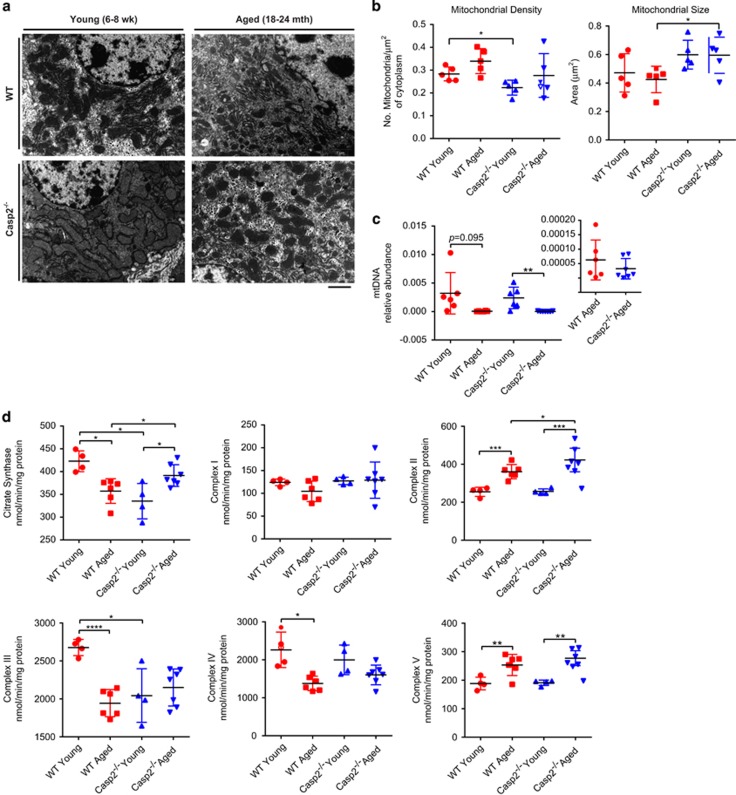
Altered mitochondria and OXPHOS in the livers of Casp2−/− mice contributes to ageing. (a) Representative electron microscopic images of hepatocyte mitochondria in the liver sections. Images representatives of 3–5 fields of view for each individual sample. (b) Hepatocyte mitochondria density (no. of mitochondria/μm2 of cytosplasm) measured from images of 3–5 fields of view for each individual and mitochondria size measured from >80 mitochondria across 3–5 fields of view for each individual (n=5/group). (c) Mitochondrial DNA (mtDNA) content as measured by qPCR. (d) Mitochondrial citrate synthase and OXPHOS complex enzyme activity in isolated mitochondria. Values are means±S.D. *P<0.05; **P<0.01; ***P<0.001, ****P<0.0001 (n=4–6/group). See Supplementary Figure S6